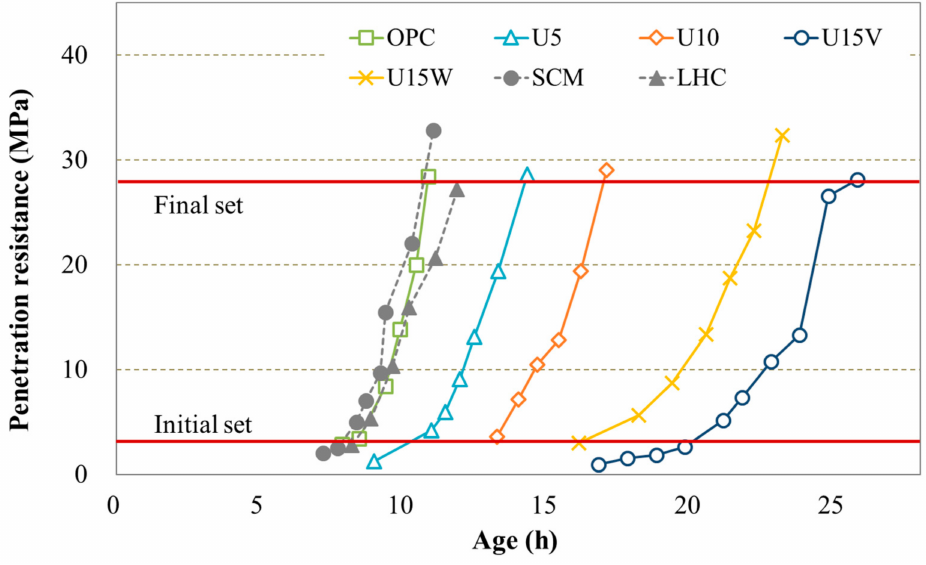
Figure 2. Setting time of the concrete